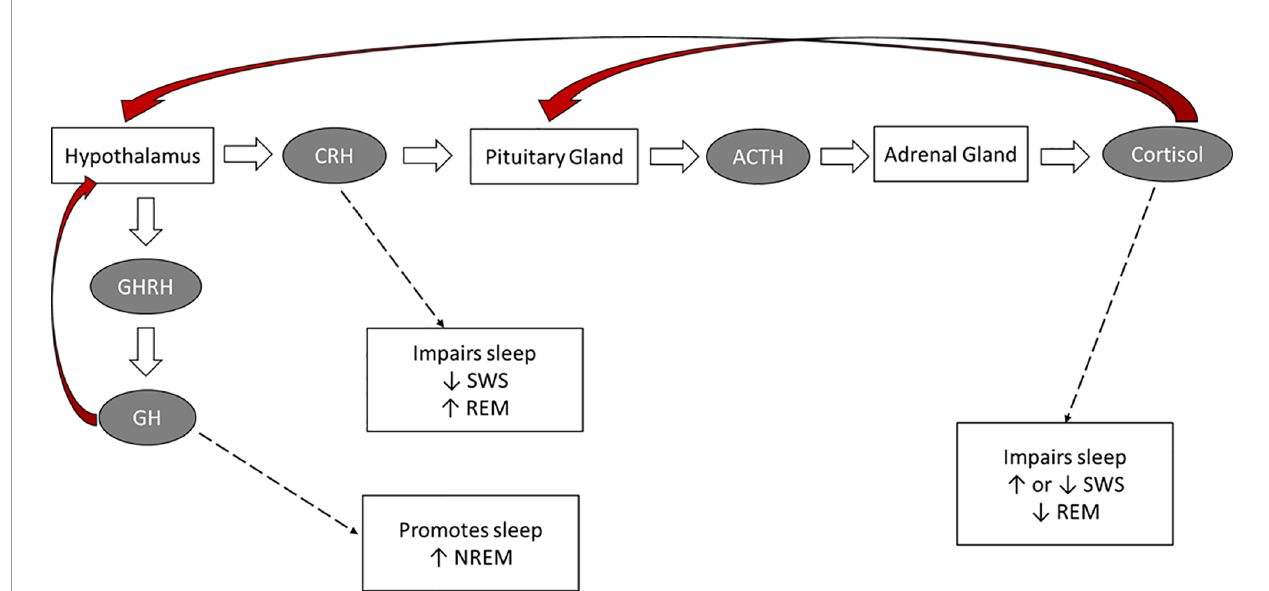
FIGURE 1 | The hormonal control of sleep. Red arrows: negative feedback on the indicated brain